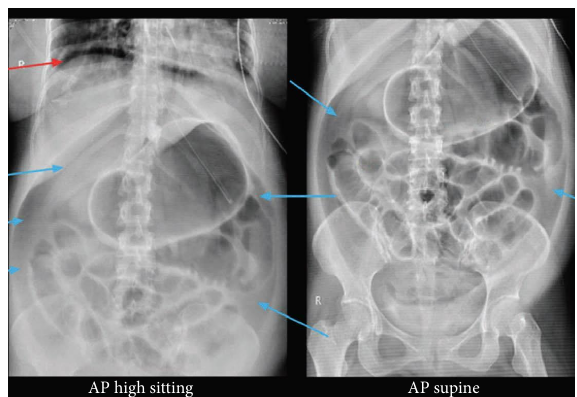
Figure 3: Scout flm of the abdomen. Follow-up study to the previous scout flm of the abdomen, now demonstrates extensive amount of free intraperitoneal air as pointed by the blue arrows with lucency in the subdiaphragmatic area as pointed by the red arrow. Description: interval demonstration of extensive amount of pneumoperitoneum with scanty to absent colonic gas in the present study; regression of the ileus; gastric distention.